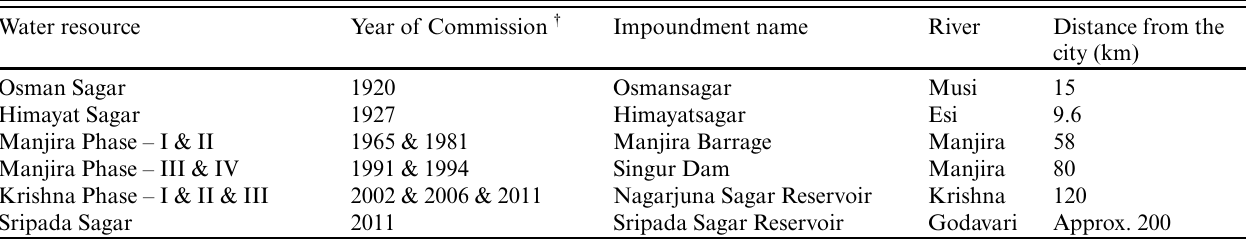
Table 2 . Hyderabad water supply resources. Sources: Van Rooijen et al. 2005, Greater Hyderabad Municipal Corporation 2006 b , Hyderabad Metropolitan Water Supply and Sewerage Board 2008 b , George et al.